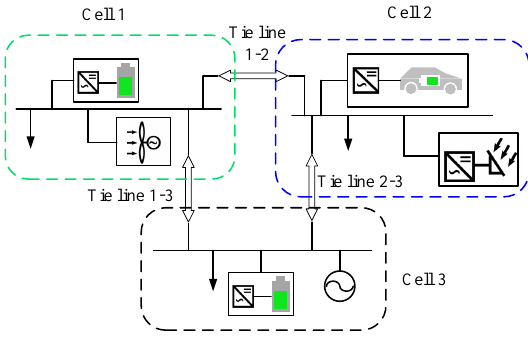
Figure 1. An example of a three-cell small scale power